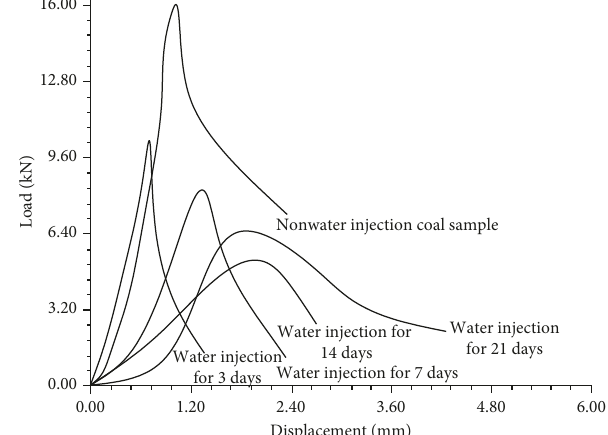
Figure 9: The stress-strain curve of water softening coal specimens.